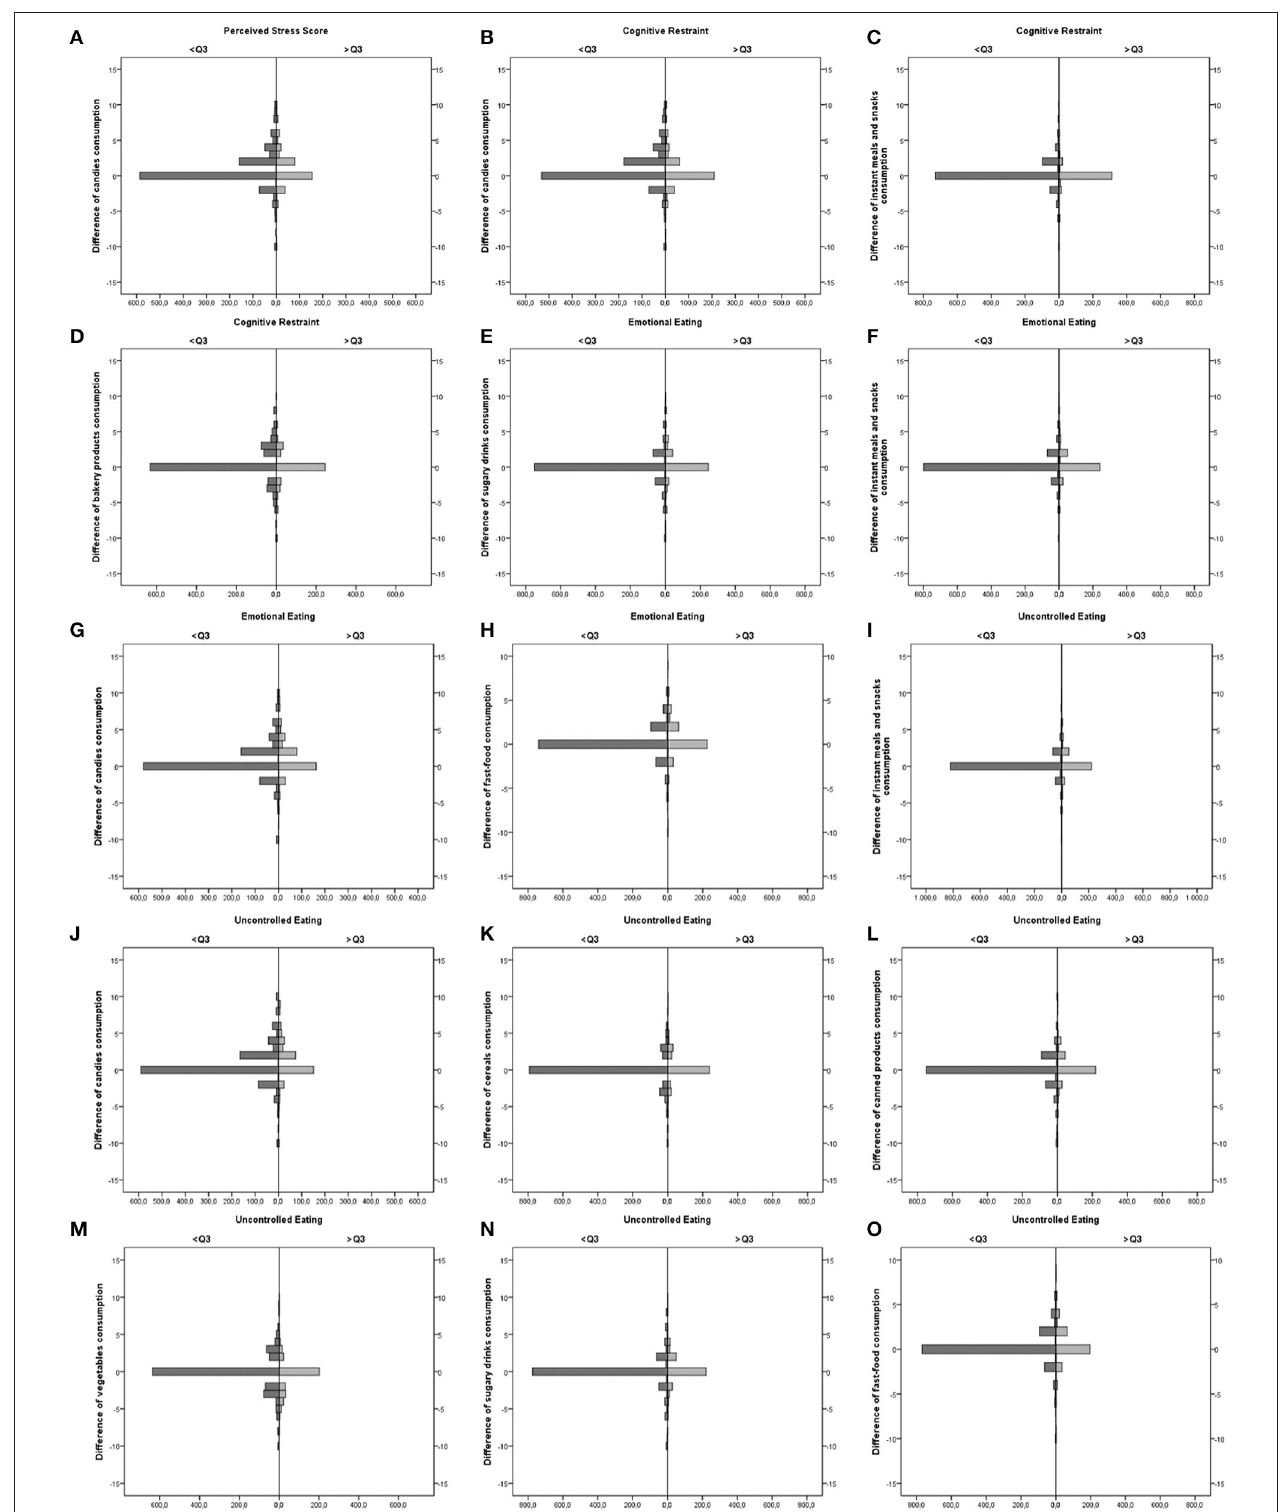
FIGURE 2 | Difference of food consumption among Brazilians who were under and above the third quartile of perceived stress, cognitive restraint (CR), emotional eating (EE), and uncontrolled eating (UE) scores. (A) Difference of candies consumption among Brazilian who were below and above the 3rd Quartile of Perceived